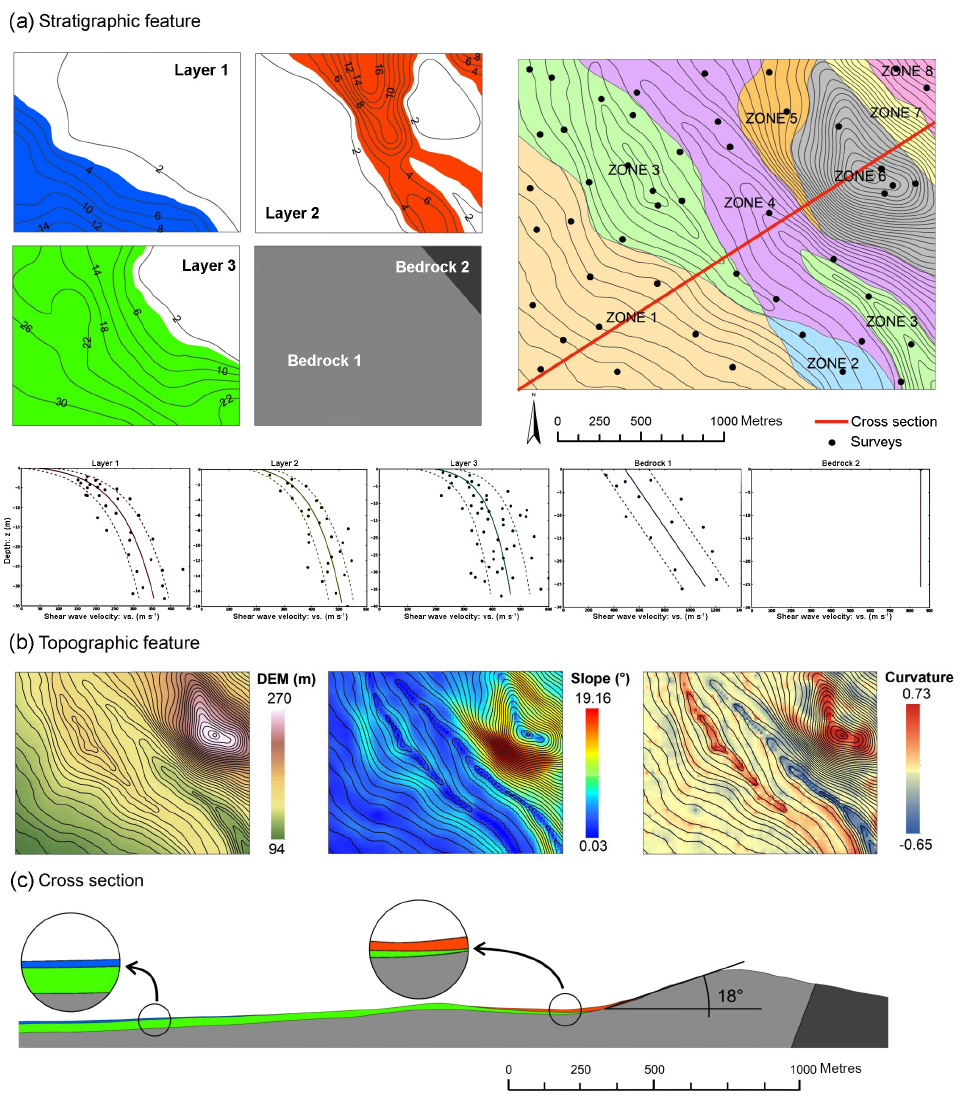
Figure 1. Synthetic recurrent scenario (SRS). (a) On the left: the maps with a resolution of 2.00m regarding the covered layers and bedrock layers; for each covered layer, the iso-thicknesses of the relative lithodynamic unit, resulting from the interpolation of the hypothesized field survey is reported (black point in lithodynamic units map); the coloured polygon is the correct extension of the unit corresponding to an iso-thickness of 3.00m (Sect. 2.2); on the right: the zones characterizing the synthetic recurrent scenario (SRS) are shown; (b) topographic features in terms of the DEM (digital elevation model), slope, and curvature maps with a resolution of 30m.; (c) cross section with zoom of the covered lithodynamic units